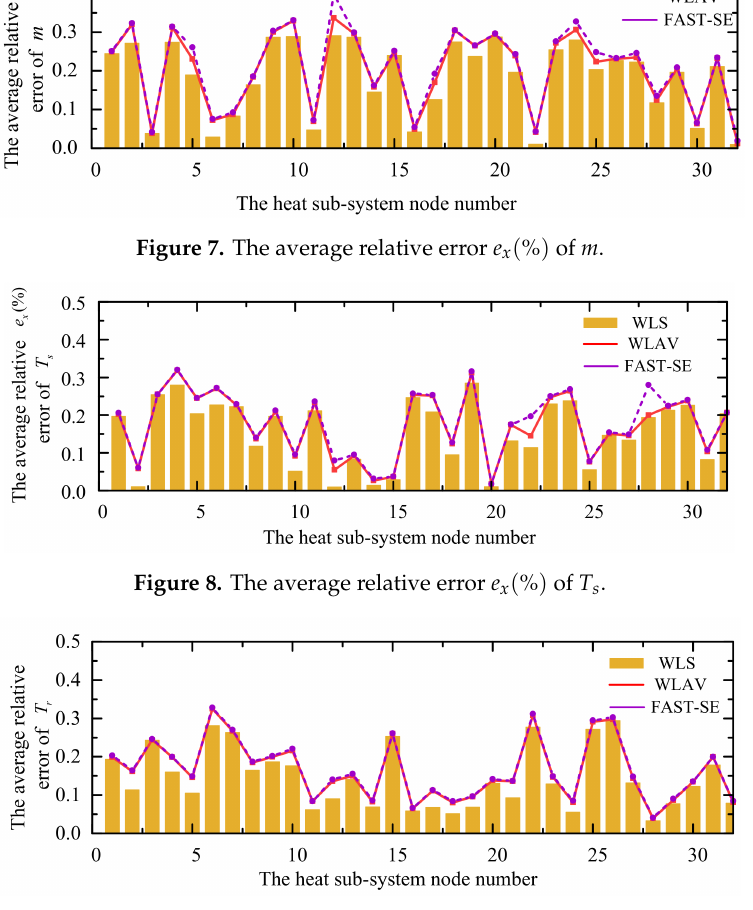
Figure 9. The average relative error e x ( % ) of T r